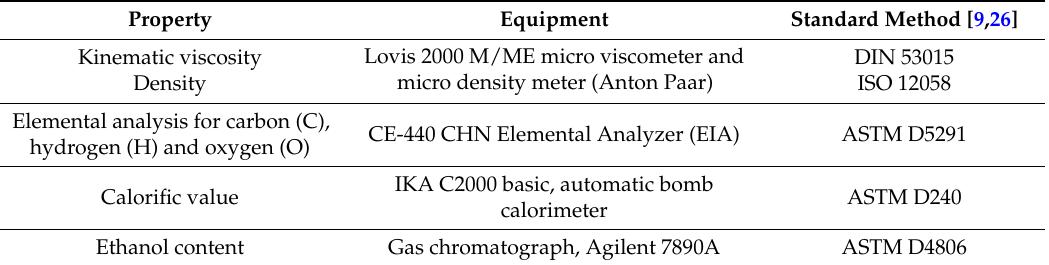
Table 2. List of equipment used to analyse the properties of the M. glaziovii bioethanol. CHN: carbon, hydrogen, nitrogen. Property